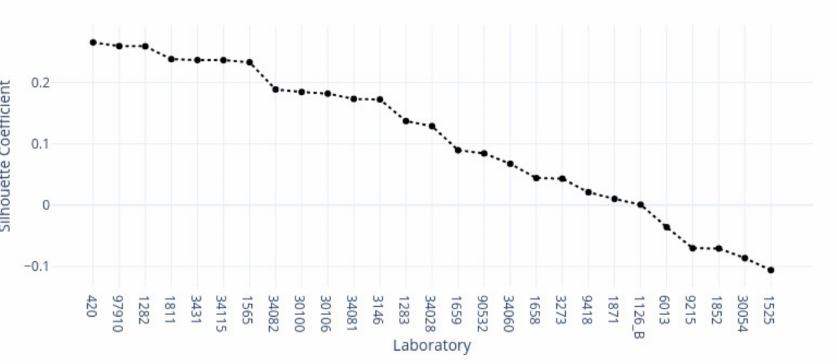
Figure 14. Silhouette scores for the first found cluster (C1) in skin samples across laboratories.